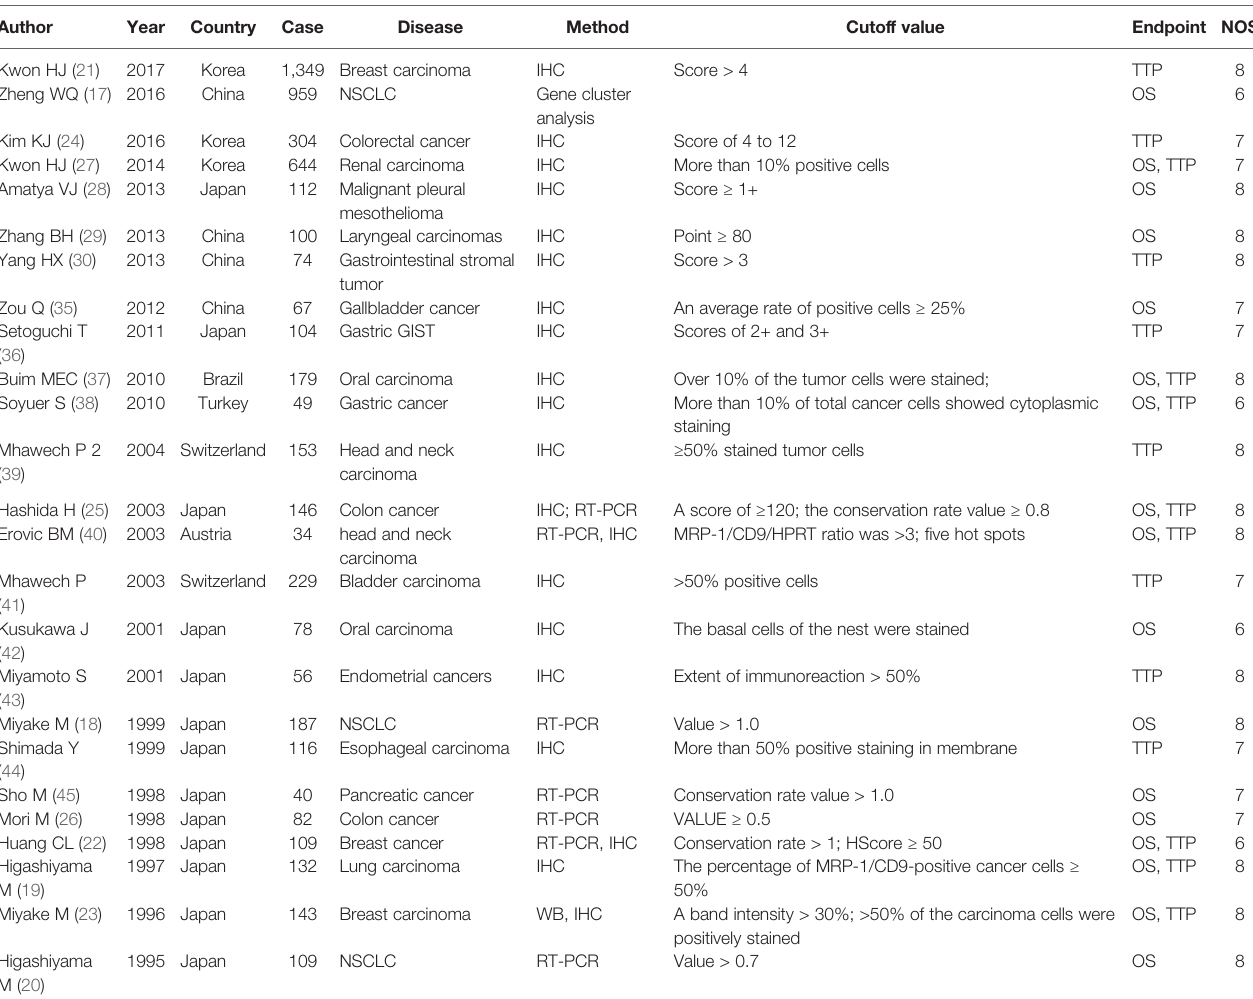
TABLE 1 | Characteristics of studies included in the